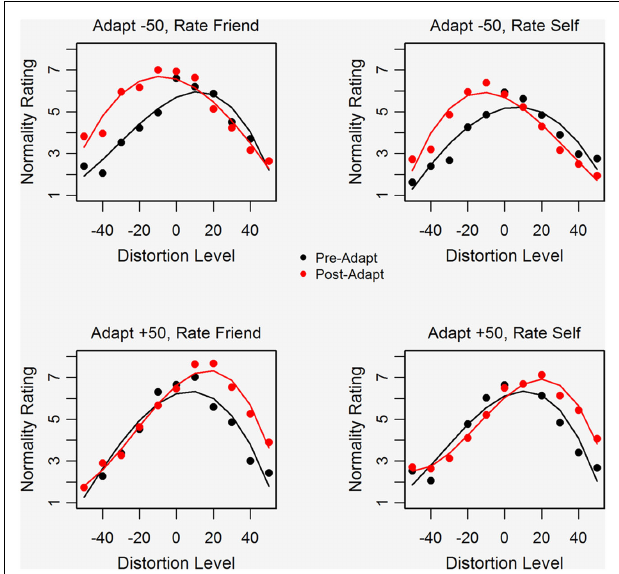
FIGURE 2 |Average normality ratings plotted as a function of face distortion level using black symbols for pre-adaptation ratings and red symbols for post-adaptation ratings. The right and left panels show ratings for Self and Friend respectively, for conditions in which participants adapted to compressed faces (top panel) or to expanded faces (bottom panel).